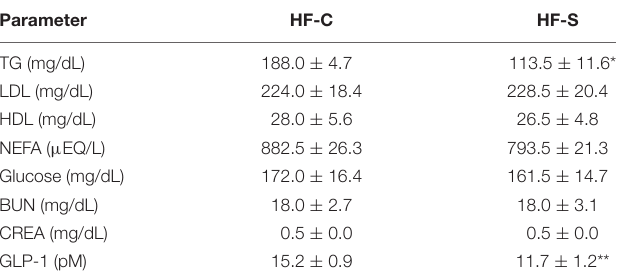
TABLE 2 | Levels of lipids, GLP-1 activity, and other biochemical